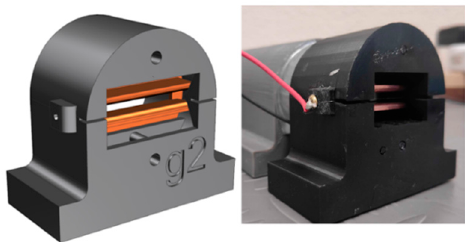
Figure 2. Three-dimensional design and prototype of EMBID configuration.